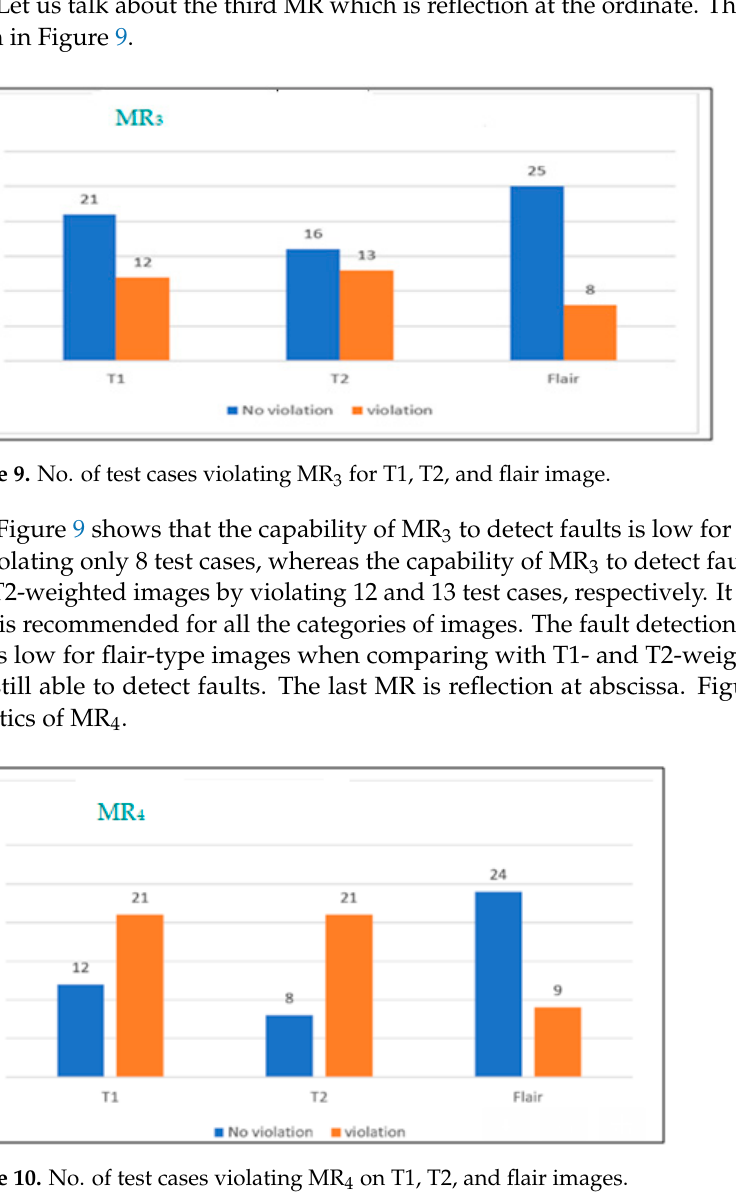
Figure 8. No. of test cases violating MR 2 for T1, T2, and flair images.